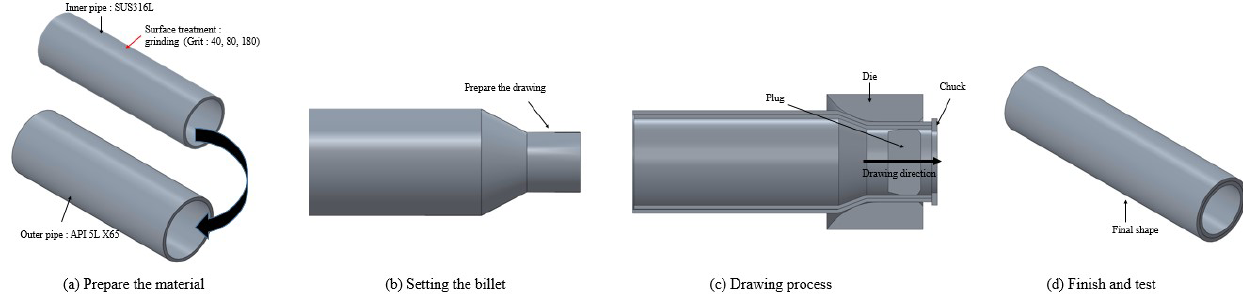
Figure 1. Schematic illustration of the drawing process.